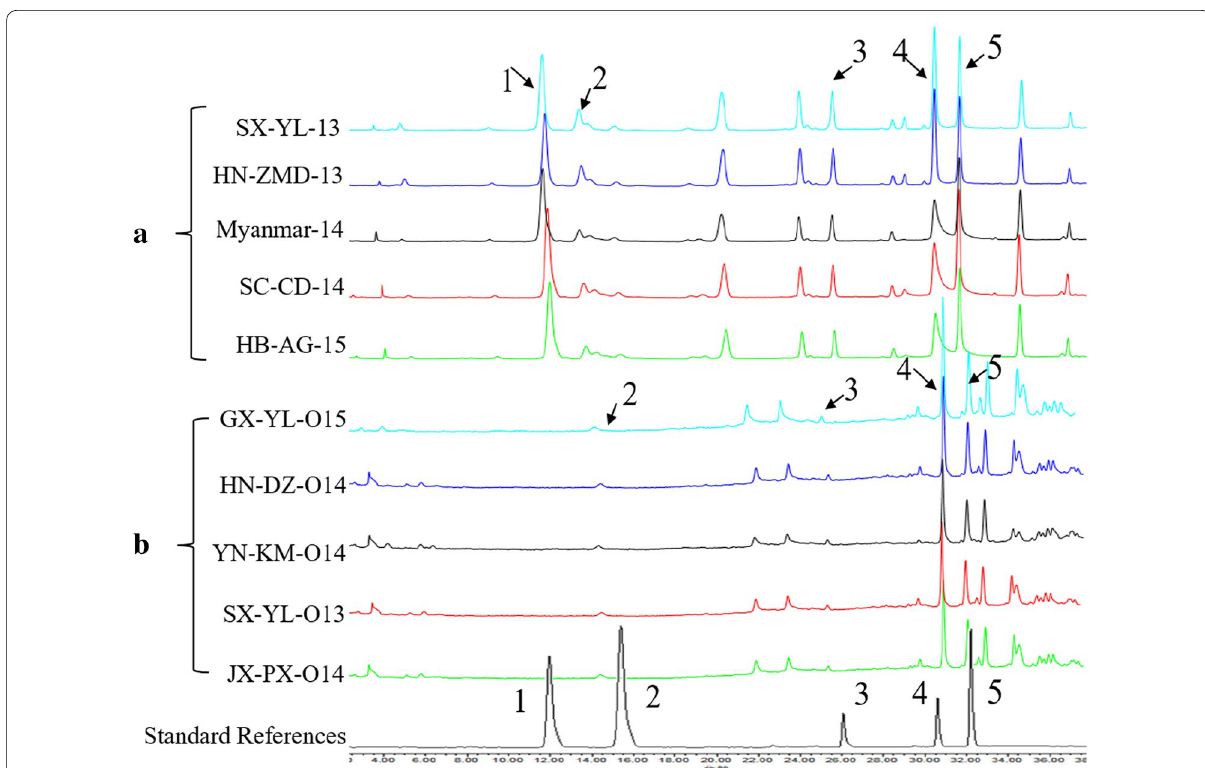
Fig. 4 HPLC fingerprints of five S. obtusifolia ( a ) and S. occidentalis samples ( b ). Standard references from 1 to 5 represented aurantio-obtusin, emo- din, aloe-emodin, chrysophanol and physcion,